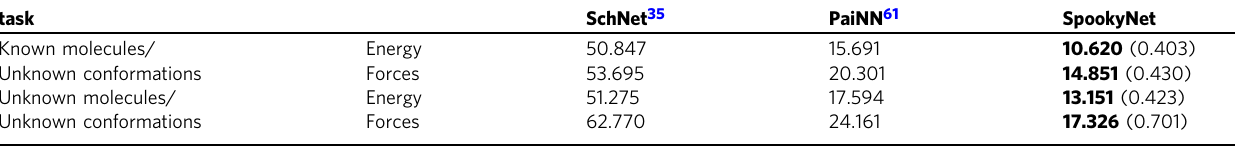
Table 2 Mean absolute errors for energy (meV) and force (meV Å − 1 ) predictions for the QM7-X 71